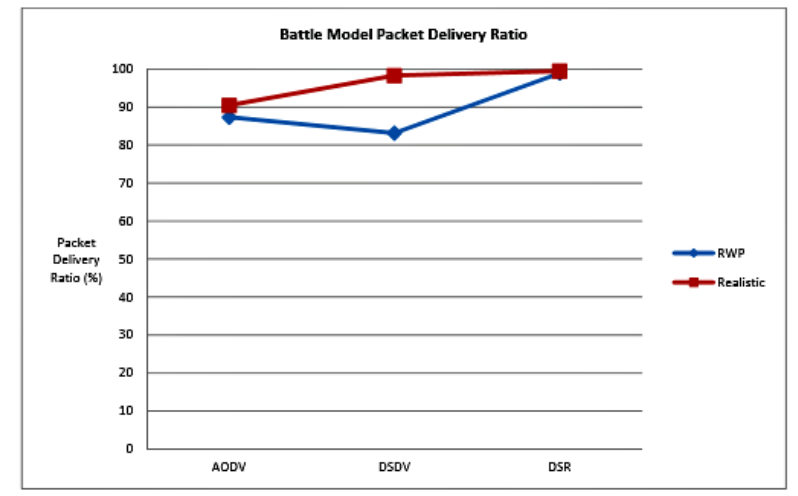
Figure 9. Packet Delivery Ratios for our Battlefield Model. RWP: random waypoint method.